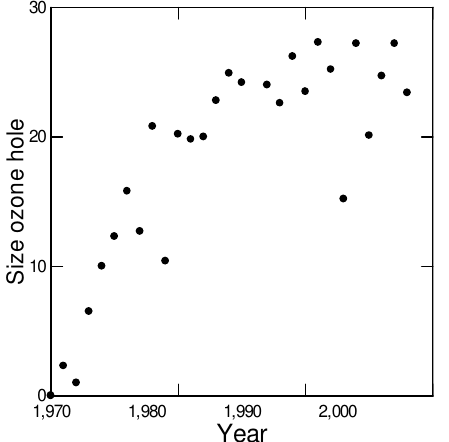
Figure 5. Stabilization of the springtime size (millions km 2 7 September–13 October) of the Antarctic ozone hole since the middle of the 1990s